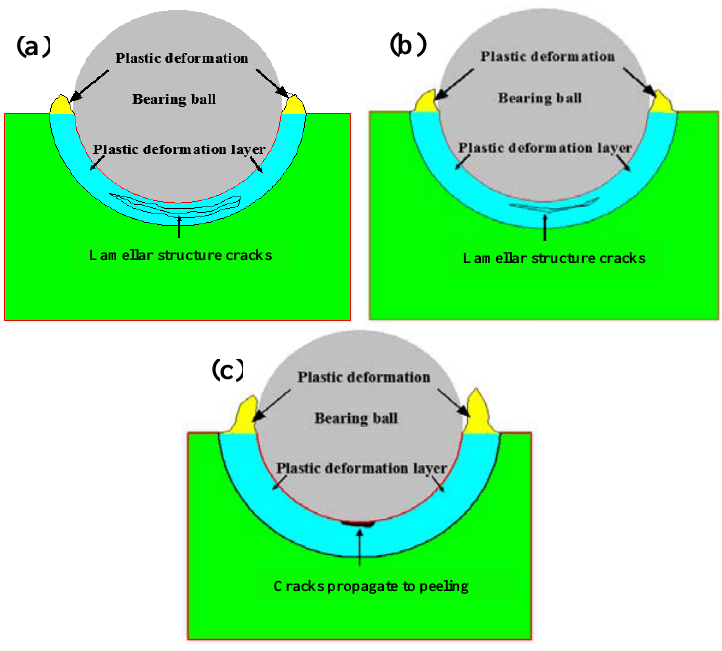
Figure 10. Schematic of fatigue damages: ( a ) Quenched at 900 °C contact stress 3.2 GPa and 543,400 cycles to failure; ( b ) Quenched at 1000 °C contact stress 3.2 GPa and 572,000 cycles to failure; and, ( c ) Quenched at 1100 °C contact stress 3.2 GPa and 566,000 cycles to failure.